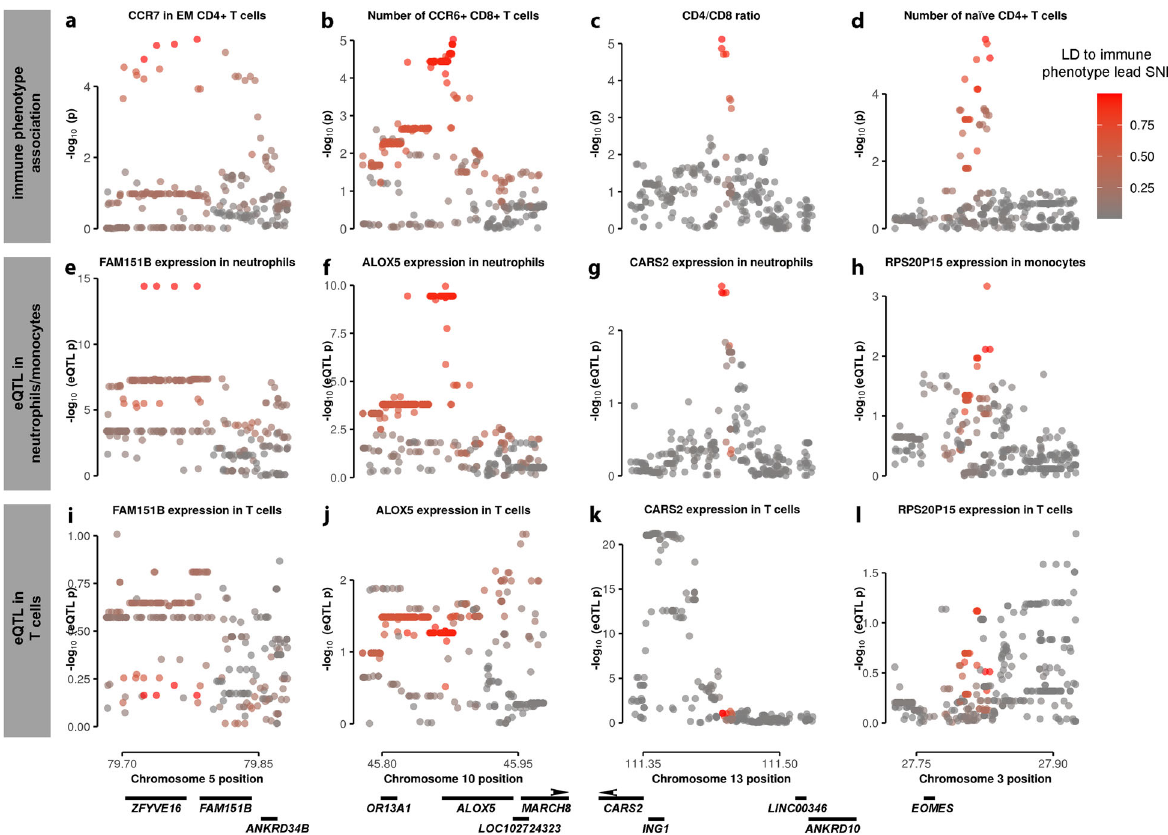
Fig. 2 Shared genetic effects between gene expression traits in neutrophils or monocytes, but not in T cells, with immune phenotypes measured in T cells. Shared association signals for different T cell immune phenotypes ( a – d ) and gene expression traits (expression traits quantitative loci, eQTLs) in neutrophils or monocytes ( e – h ). There were no consistent association signals for these gene expression traits in T cells ( i – l ). The genetic variants are shaded by linkage disequilibrium (LD, r 2 ) to the immune phenotype lead single nucleotide polymorphism